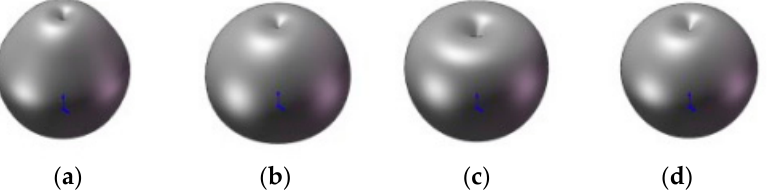
Figure 2. Geometric models of typical pears. Snow pear ( a ); Crisp pear ( b ); Qiuyue pear ( c ); Huangguan pear ( d ). Note: Blue is the origin of the coordinate system for the pear geometric model. The “.stp” format of these models was imported into EDEM. Using the pear contour